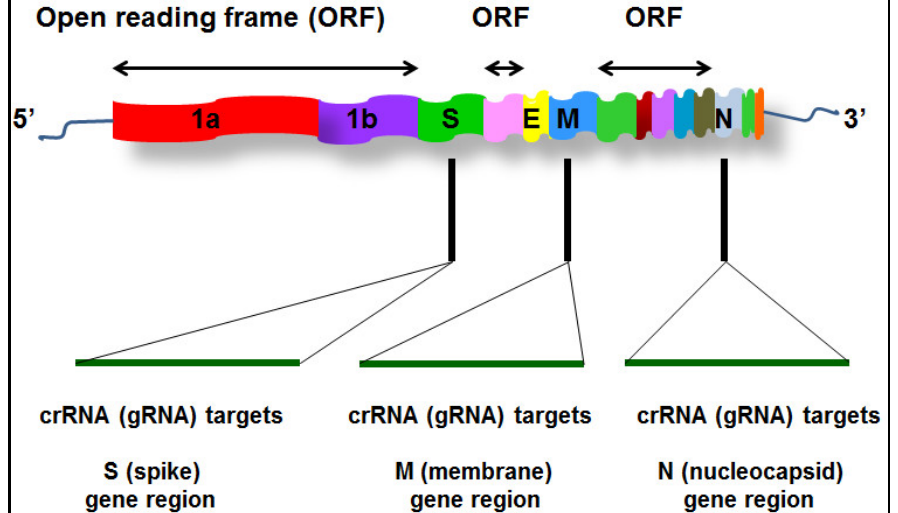
Figure 1. Schematic of severe acute respiratory syndrome coronavirus 2 (SARS-CoV-2) gene structure and locations of three crRNAs (gRNAs) designed to specifically target three genes (S, M, and N) of the virus, respectively.